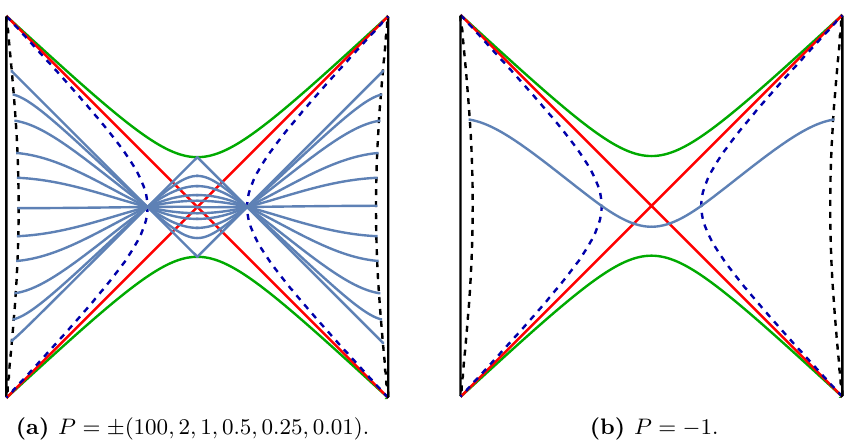
Figure 6. Penrose diagrams for the centaur geometry and geodesics anchored at different boundary times in blue, spanning the full range of times for which smooth spacelike geodesics of finite length exist. The dashed black line is the cutoff surface with R b = 10 . The dark blue dashed line is the interpolating line between the two geometries at r = 0 . The red lines correspond to the horizons and the green ones correspond to r → −∞